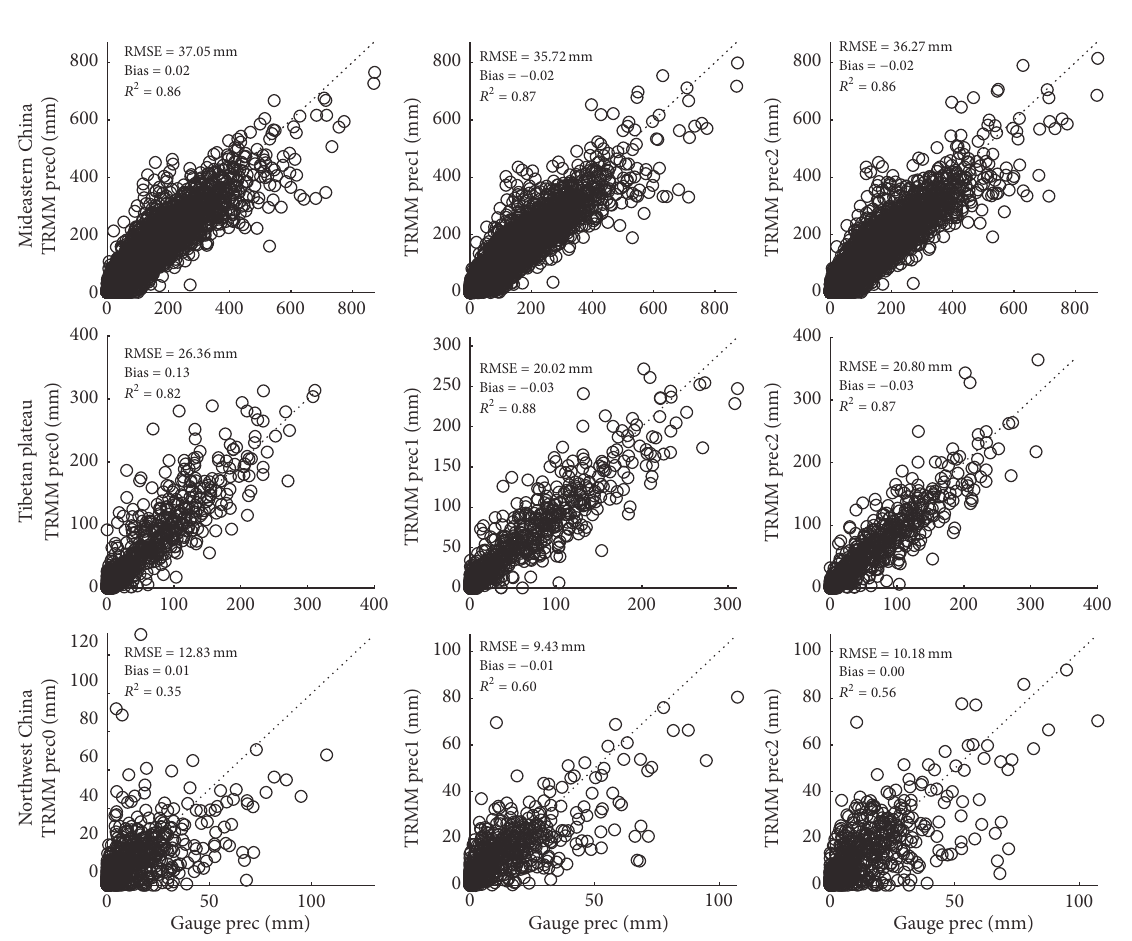
Northwest China. The possible reason is that station